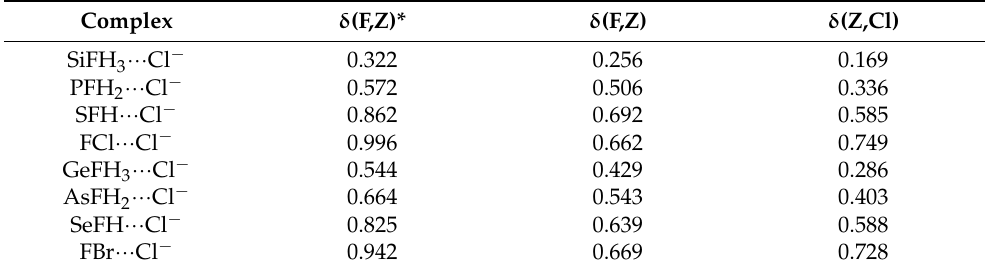
Table 4. Delocalization indices for the F–Z and Z–Cl bonds, δ (F,Z) and δ (Z,Cl), respectively. δ (F,Z)* is the delocalization index for the F–Z bond of the isolated Lewis acid unit.